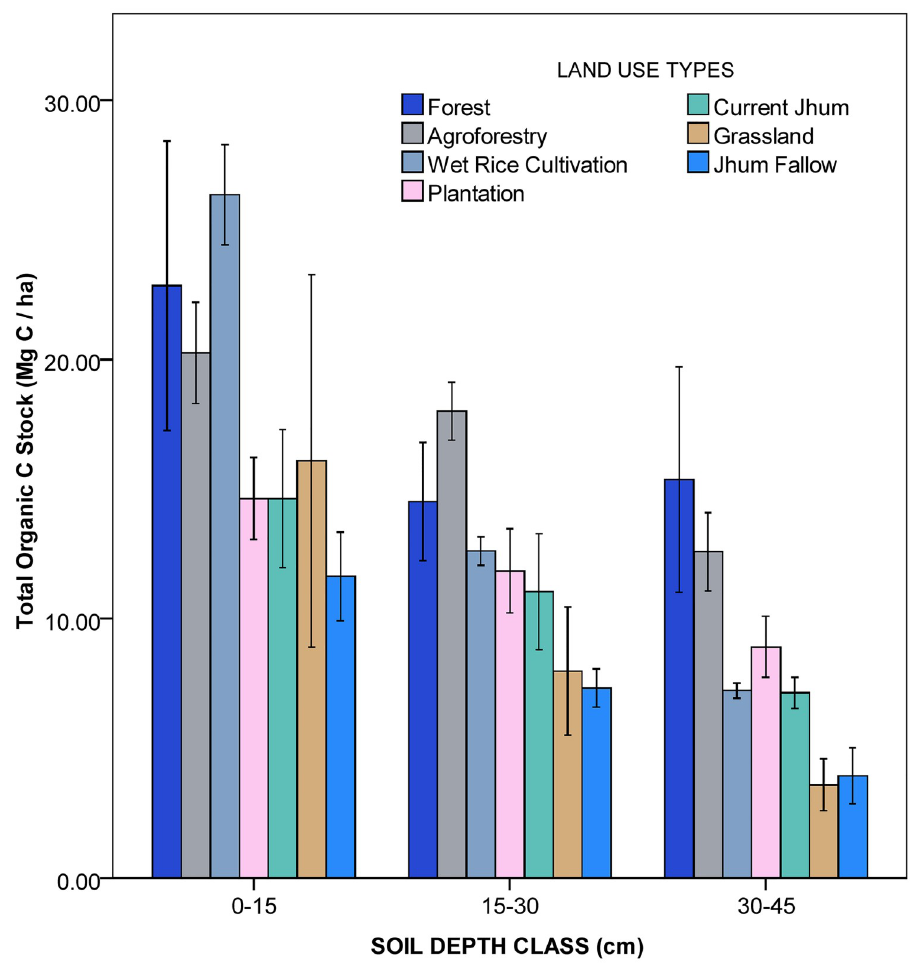
Fig 3. Soil organic carbon stock (Mg C ha -1 ) at different soil depth in different land use types in